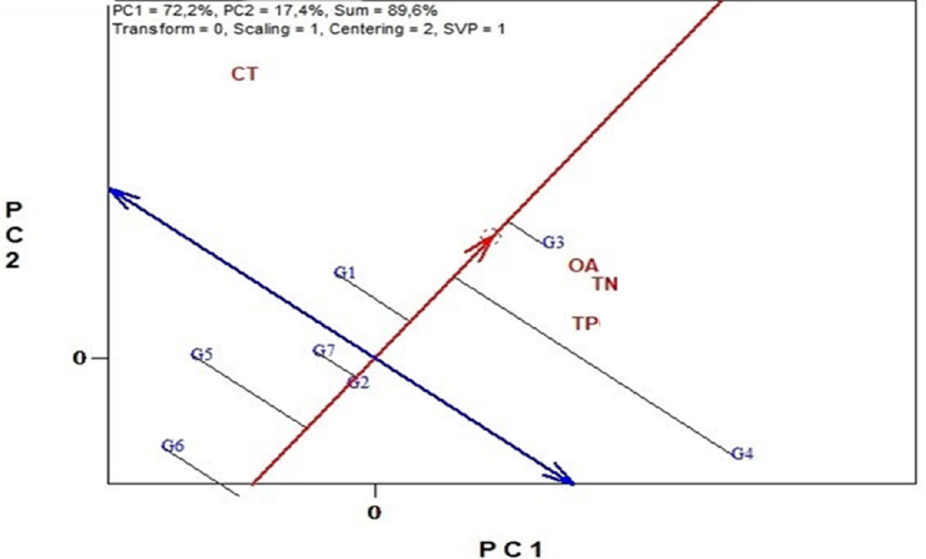
Figure 10. “Mean vs. Stability” view of the GGE biplot for seven genotypes of V. sativa of four antinutritional traits, averaged across six environments.